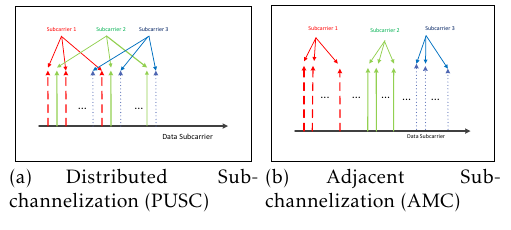
Figure 7. LTE OFDMA Frame Structure